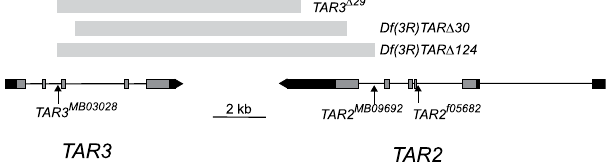
Figure 1. Genomic organization of the TAR2 and TAR3 genes. Boxes indicate exons, with lighter shading indicating coding regions and darker shading indicating untranslated regions. The precise sizes of the deletions created in this study are 12,084 bp ( Df ( 3R ) TAR Δ 124 ), 10,367 bp ( Df ( 3R ) TAR Δ 30 ), and 9,294 bp ( TAR3 Δ 29